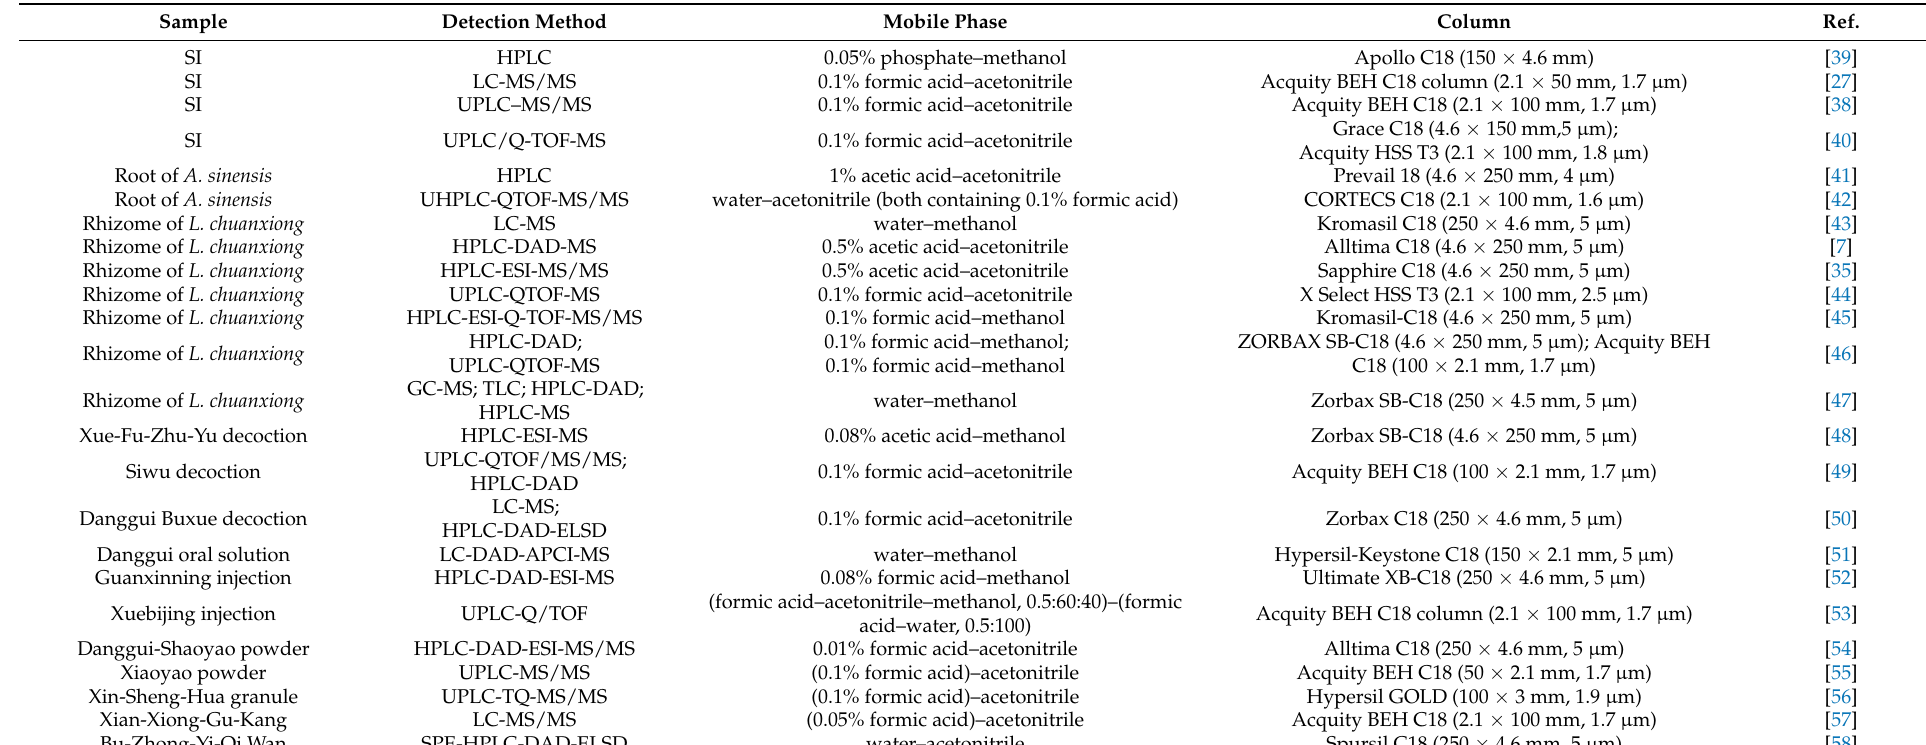
Table 1. Analytical methods and their main